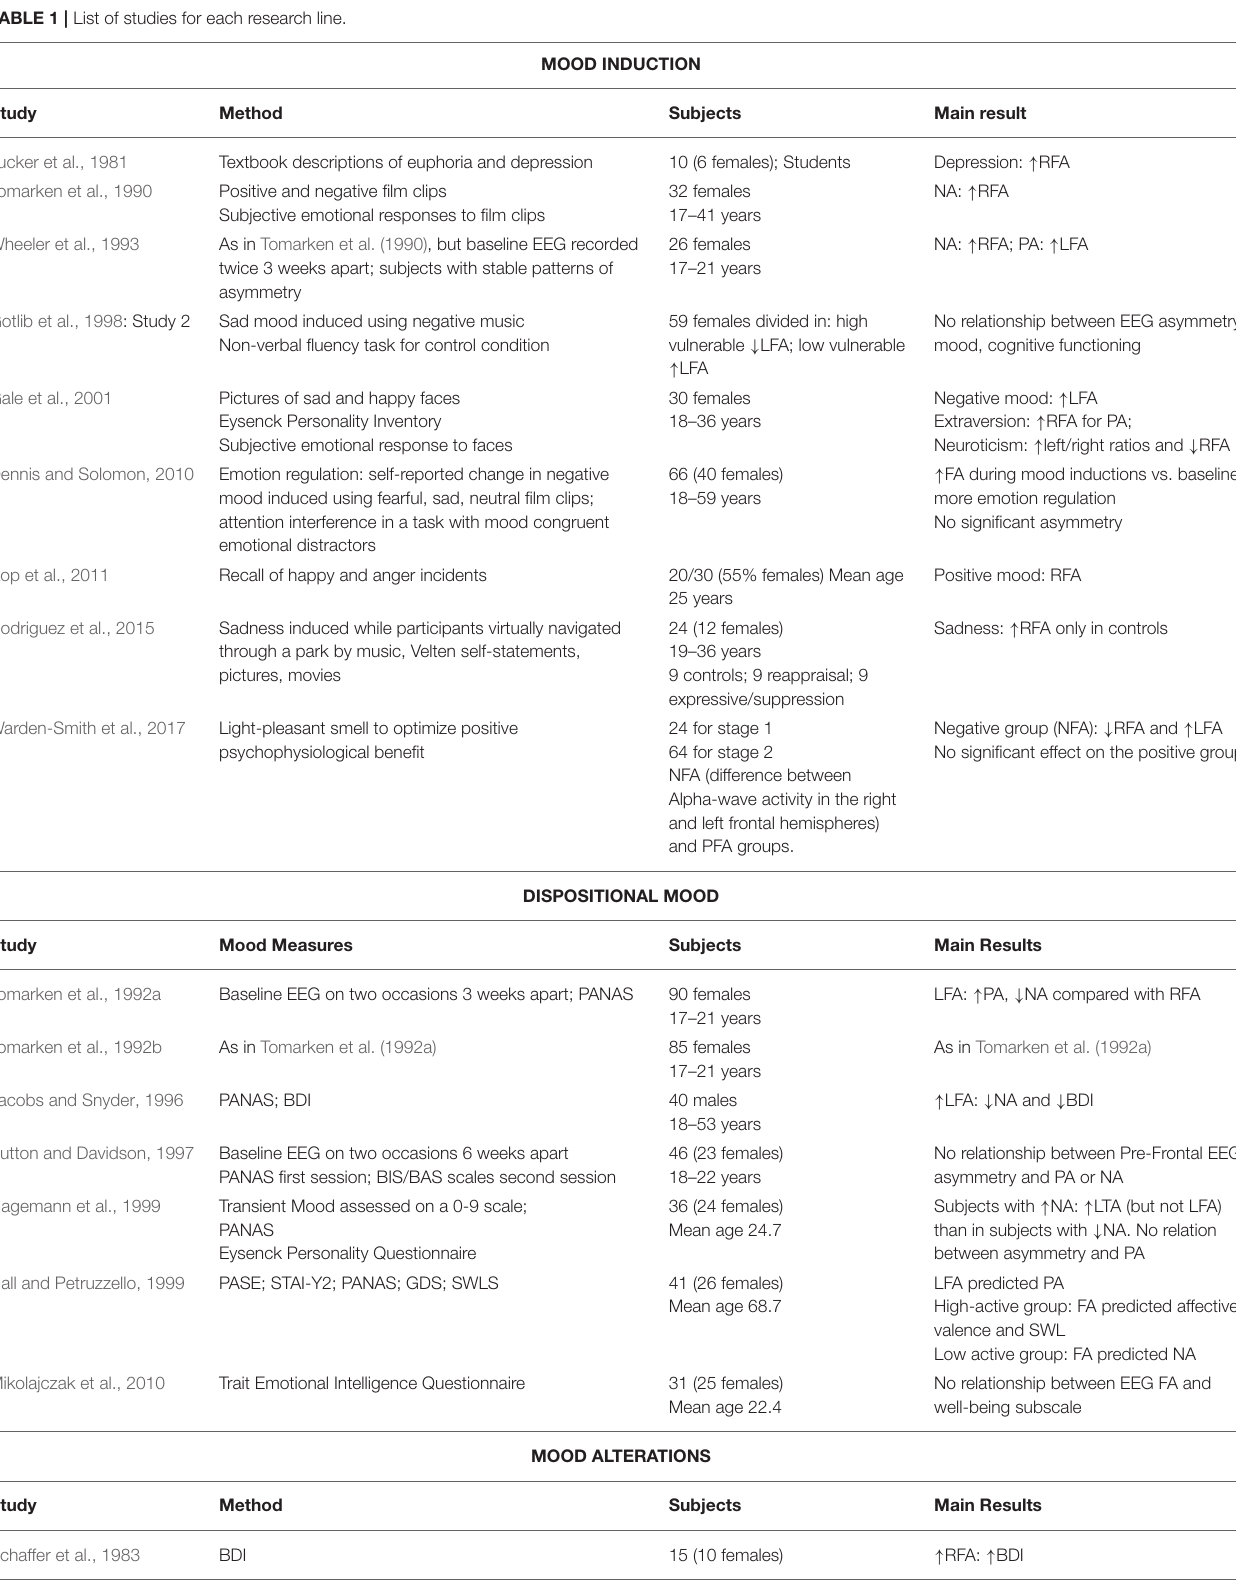
TABLE 1 | List of studies for each research